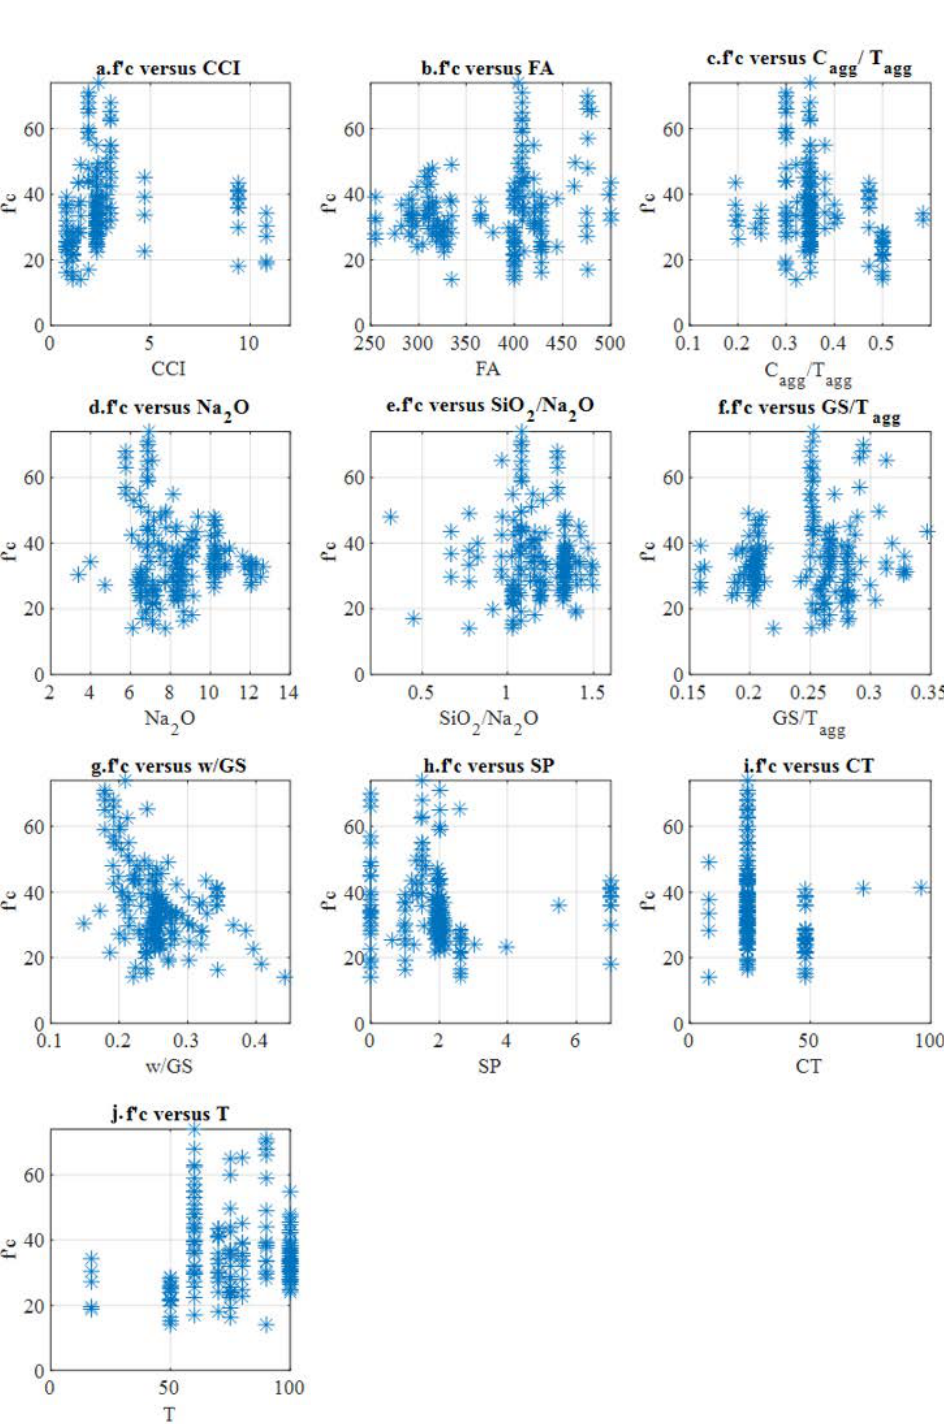
Figure 3. Compressive strength of the FA geopolymer concrete (f’c) versus selected input variables: ( a ) f’c versus CCI, ( b ) f’c versus FA, ( c ) f’c versus C agg /T agg , ( d ) f’c versus Na 2 O, ( e ) f’c versus SiO 2 /Na 2 O, ( f ) f’c versus GS/T agg , ( g ) f’c versus w/GS, ( h ) f’c versus SP, ( i ) f’c versus CT and ( j ) f’c versus